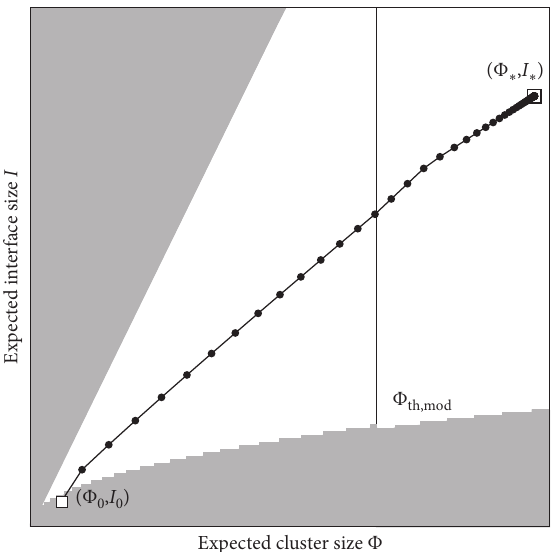
Figure 6: The evolution of the iteration shown in the ( Φ ,I ) plane. The initial position and the fixed point are denoted by empty and filled squares, respectively. The solid line and the dots show the evolution of ( Φ k , I k ) . The vertical line marks Φ th , mod